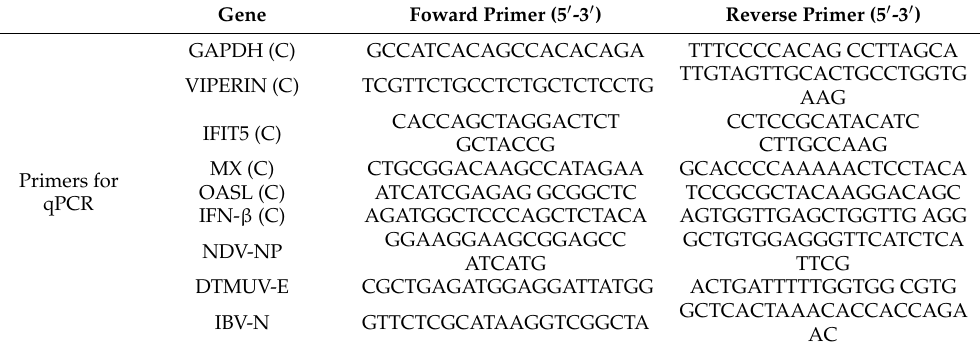
Table 1. The gene specific primers for